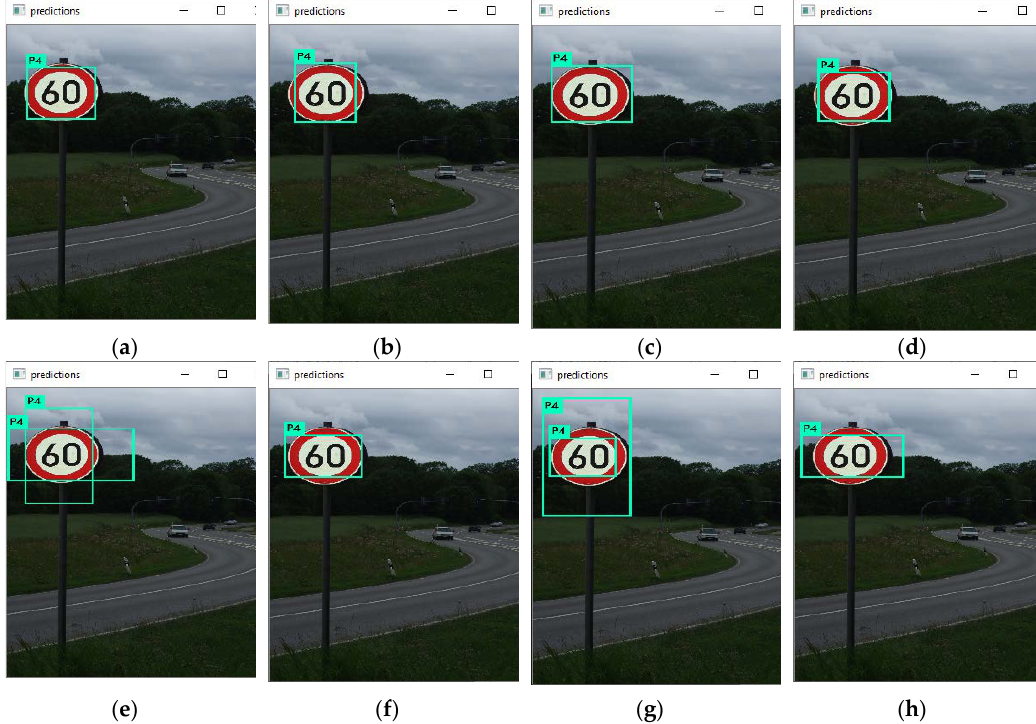
Figure 9. Taiwan’s prohibitory sign (Class P4, Image P4-5.jpg) recognition result using ( a ) Yolo V3, ( b ) Yolo V3 SPP, ( c ) Densenet, ( d ) Densenet SPP, ( e ) Resnet 50, ( f ) Resnet 50 SPP, ( g ) Tiny Yolo V3, and ( h ) Tiny Yolo V3 SPP.